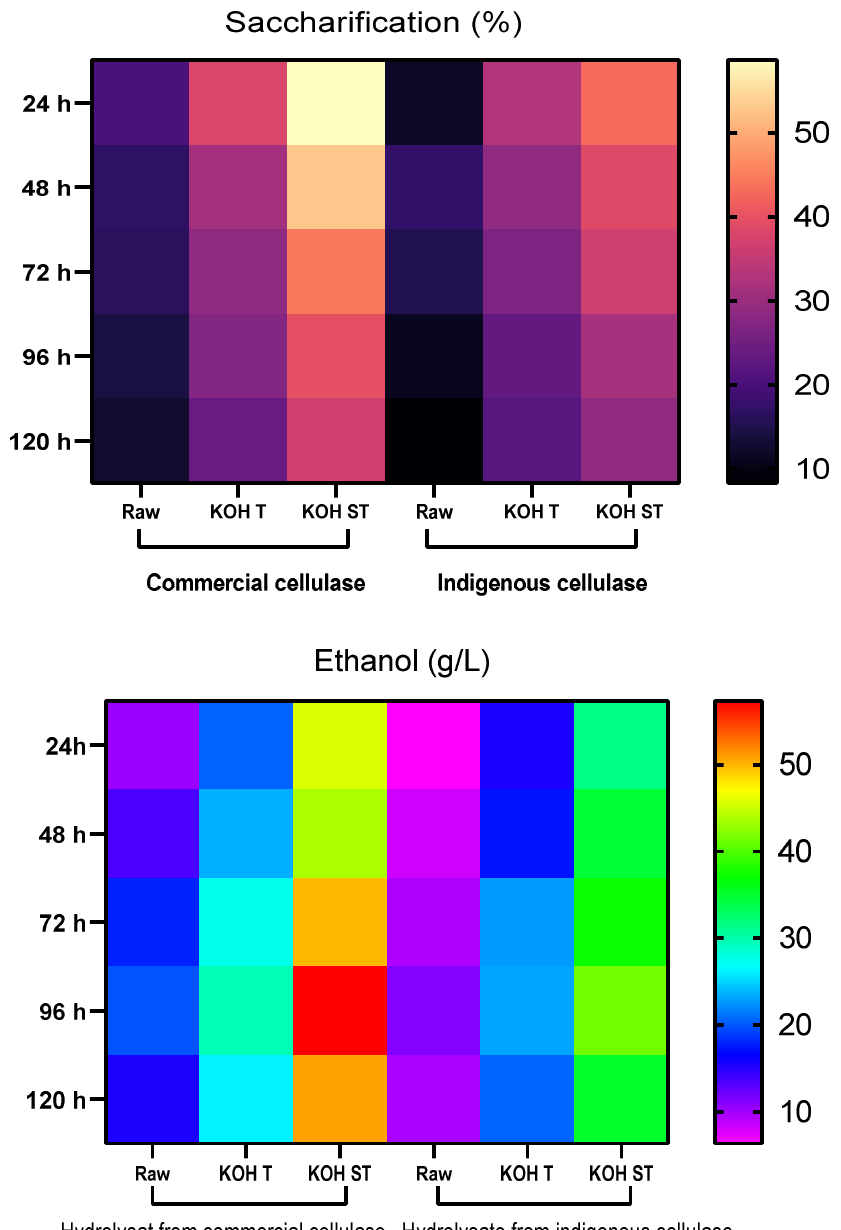
Figure 9. Saccharification (%) and ethanol production (g/L) in SSF (KOH T = KOH-treated substrate, KOH ST = KOH-steam-treated substrate).